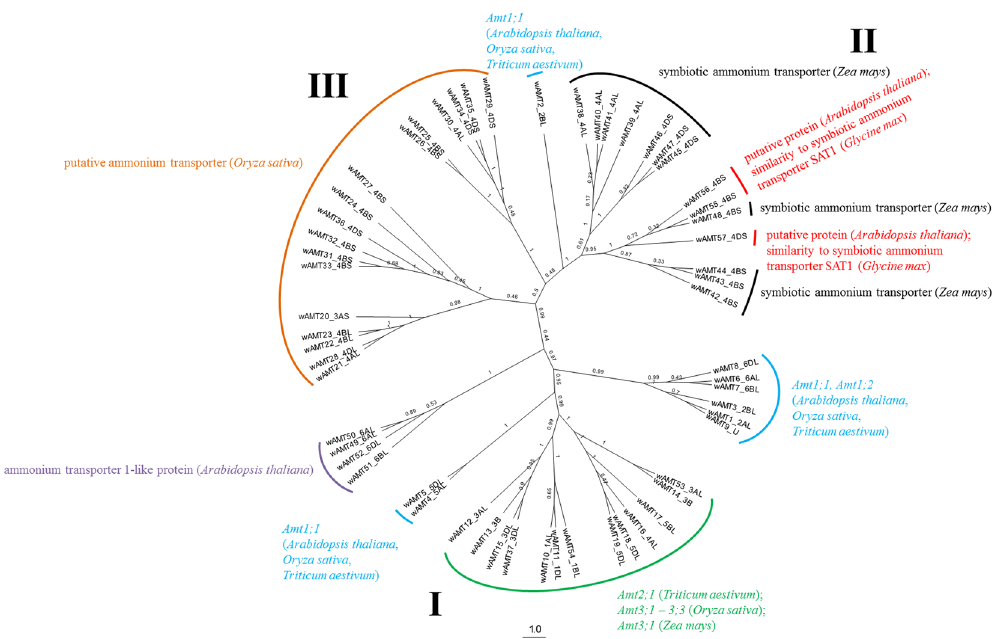
Figure 4. An unrooted Bayesian coalescent tree of wheat ammonium transporter genes constructed from multiple alignment of protein sequences. Posterior probabilities are reported for each branch. Based on the result of blastx , the taxa are annotated with either the names of known genes or with GenBank descriptions, and their plant